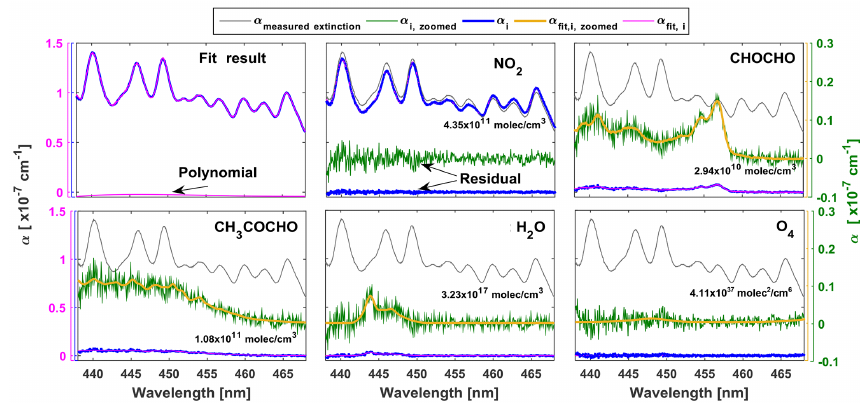
Figure 7. An example of spectral fit for one Ch 455 (10s average) measured over an agricultural burning plume on the 3 July 2013 nighttime flight during SENEX 2013. Retrievals of NO 2 , CHOCHO, CH 3 COCHO, H 2 O, and O 4 are shown, as well as the third-order polynomial, total fit, and residual. Blue and pink traces are plotted against the left axis, while the expanded green and yellow traces are plotted against the right